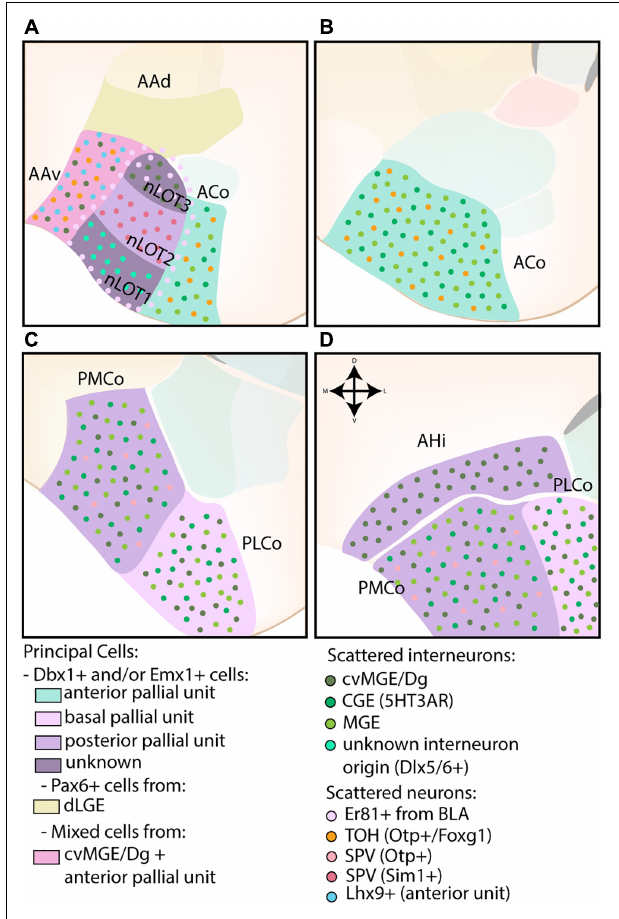
FIGURE 6 | The developmental origins of the corticoamygdaloid and transition nuclei. (A) The nucleus of the lateral olfactory tract (nLOT), located at more rostral levels, contains three layers that originate from distinct progenitor pools. While the exact molecular origin of layer 1 and 3 (nLOT1/3) is currently unknown, nLOT3 was found to contain an abundance of caudoventral MGE/Diagonal area (cvMG/Dg)-derived cells and Er81-expressing cells, the latter that might originate from the basolateral amygdala (BLA, basal pallial unit) and surrounds the entire nLOT. Scattered interneurons of unknown origin (Dlx5/6) are present in the nLOT1, which might also express Lhx9 (controversial). In contrast to nLOT1/3, the origin of nLOT2 is well-known and its principal cells are derived from the posterior pallial unit. Emx1+ cells are complemented by Sim1+ cells from the supraopto-paraventricular hypothalamus (SPV). The dorsal part of the anterior amygdala area (AAd), also visible at this level, contains a significant proportion of dLGE-derived Pax6-expressing cells. In contrast, the ventral part (AAv) contains a mix of cvMGE-derived cells, Lhx9+ cells from the anterior amygdala unit and some Otp+/Foxg1+ cells from the hypothalamus (TOH). (A–D) The corticoid nuclei of the amygdala are divided along the rostrocaudal axis into an anterior (ACo), posteromedial (PMCo), and posterolateral (PLCo) part. They are all derived from different pallial amygdalar units (anterior, posterior, and basal, resp.) and contain a mix of Dbx1+ and Emx1+ cells. Both the ACo and PMCo contain cells from hypothalamic origin (SPV), with those from ACo well-annotated to the TOH, and those from PMCo currently unknown. The entire corticoid nuclei contain scattered MGE- and CGE-derived interneurons, with the PMCo and PLCo additionally containing a subset of cvMGE/Dg-derived interneurons. (D) The amygdalo-hippocampal interface (AHi) is visible at the most caudal level and consists of cells from the posterior pallial amygdala unit (mostly Emx1+) and cvMGE-derived